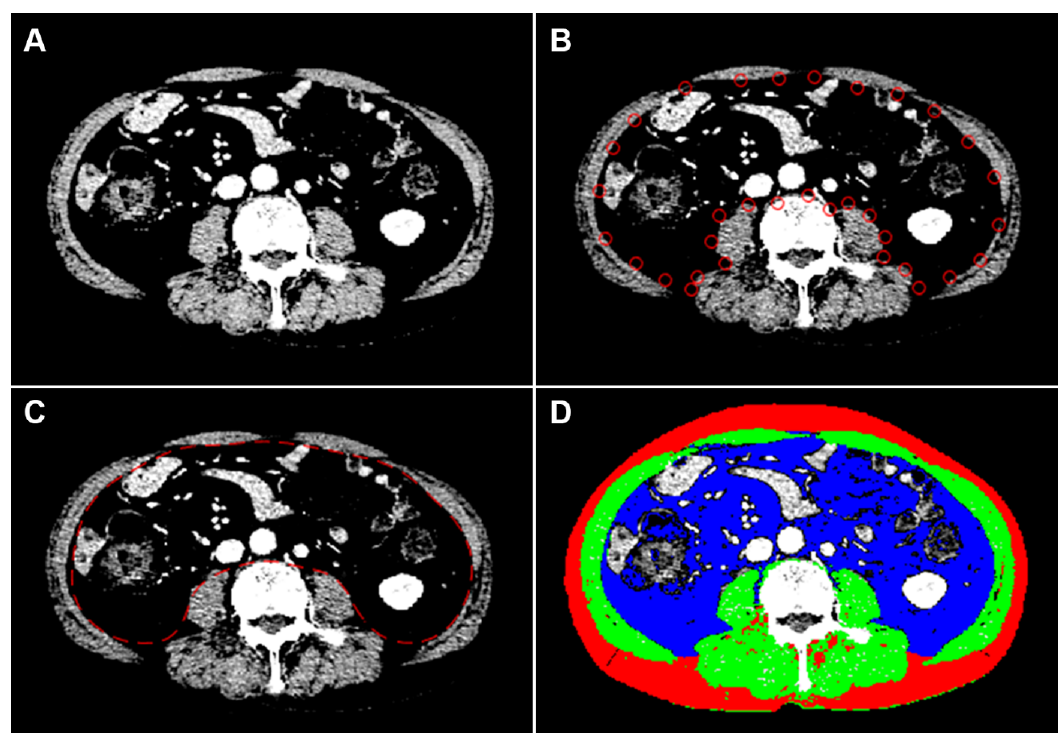
Figure 1. An example of semiautomatic quantification of body composition in a 75-year-old man with metastatic hormone- sensitive prostate cancer. To highlight the muscle boundary, the intensity of the CT image is linearly transformed into 0 to +100 HU ( A ). After semiautomatic manipulation ( B ), the boundary between the muscles and the inner tissues is detected using the active contour method by minimizing a cost function, dividing CT images into inner and outer regions ( C ). Pixels in the fat and muscle are then identified using cut-off values of − 300 to − 50 HU and − 29 to +150 HU, respectively ( D ). The cross-sectional areas of muscle, subcutaneous fat, and visceral fat are measured to be 140.03 cm 2 , 118.69 cm 2 , and 181.37 cm 2 , respectively. Green-colored, red-colored, and blue-colored areas represent muscle, subcutaneous fat, and visceral fat, respectively; CT, computed tomography; HU, Hounsfield